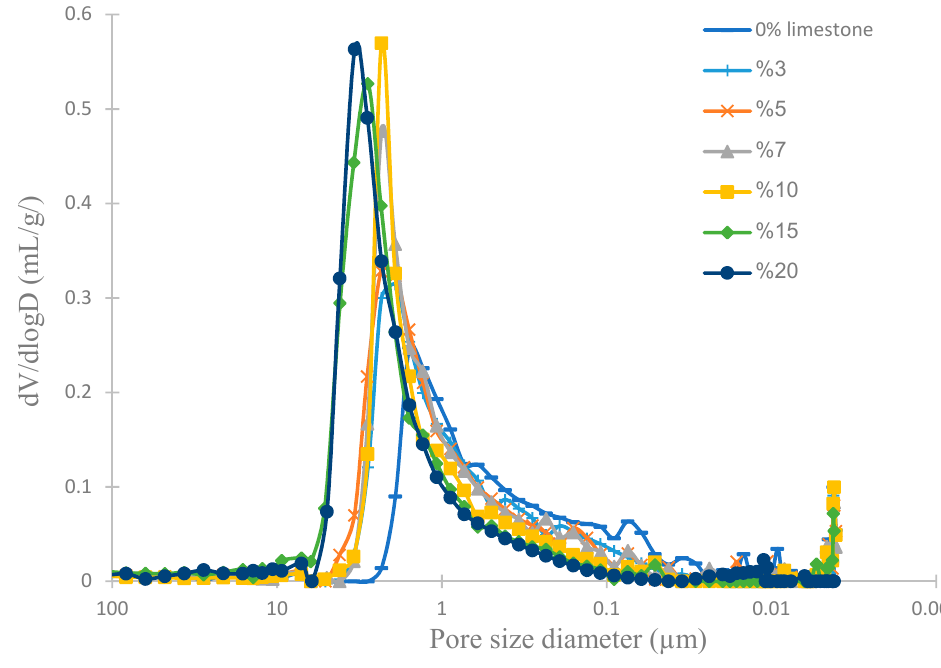
Figure 6. Membrane pore-size